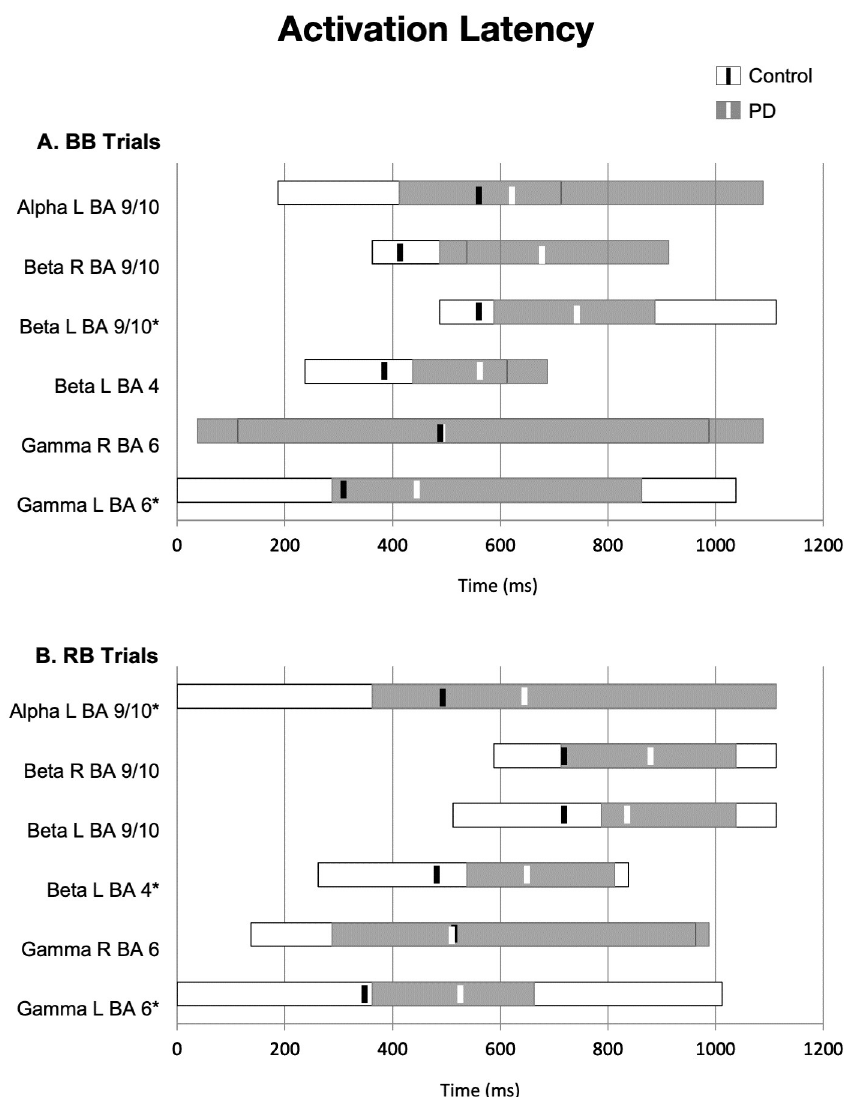
Fig 3. Activation latency. (A) Onset and duration (gray and white bars) of power change in each ROI for the matched control trials. Latency of peak power change is indicated by solid black or white lines. (B) Onset and duration of power change in each ROI for the mismatched activation condition. Peak latency was significantly longer in the PD vs. control group: � p <